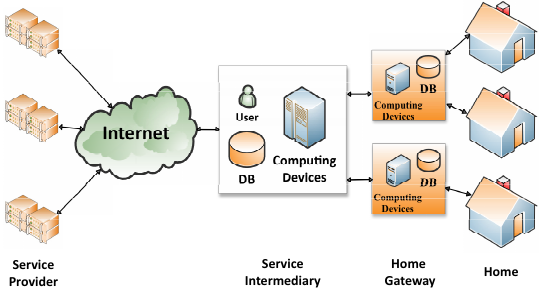
Figure 6. The structure of the Performers